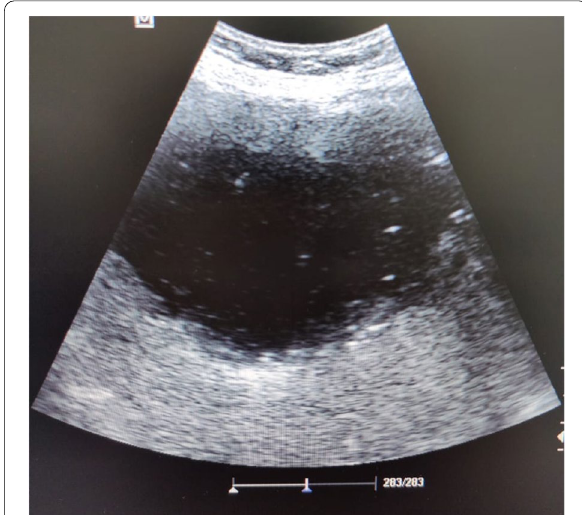
Fig. 1 Ultrasonographic picture of the right liver lobe delineating cystic like structure with fine reticulations